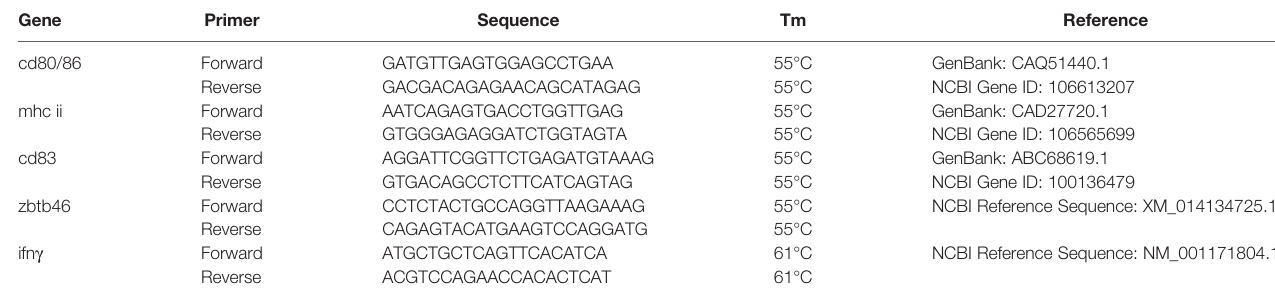
TABLE 2 | List of primers used for gene ampli fi cation by quantitative PCR.